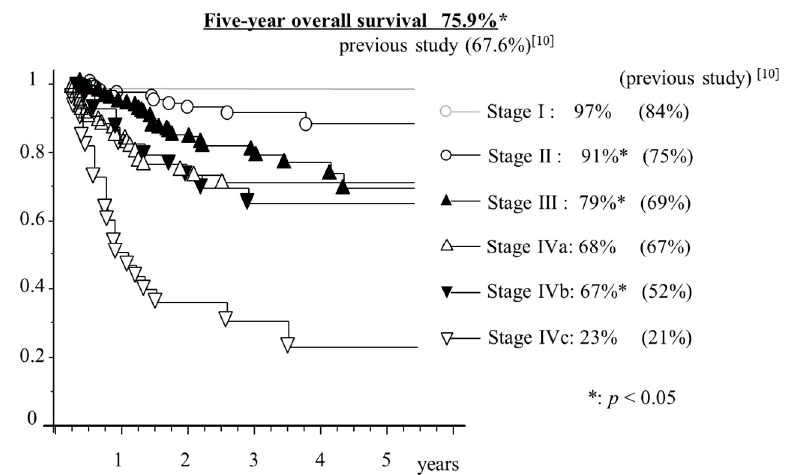
Figure 6. Kaplan–Meier curve for overall survival according to stages. Asterisks indicate significant improvement in our study compared with that reported in a previous study ( p < 0.05).